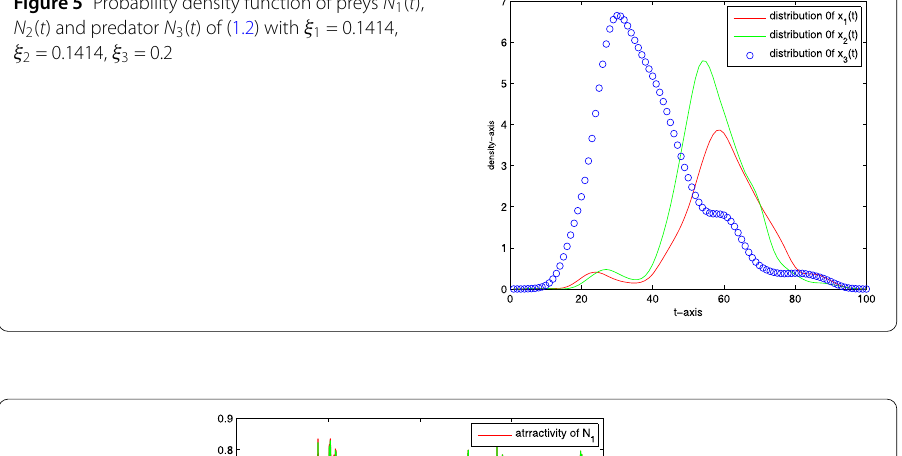
Figure 5 Probability density function of preys N 1 ( t ), N